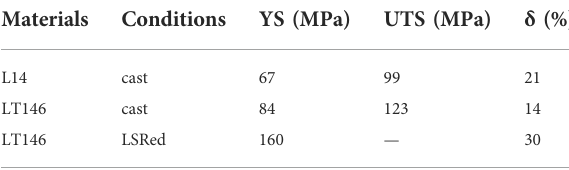
FIGURE 7 TEM images detected from the 15% deformed LT146-LSR alloy. TABLE 2 Tensile properties of the L14 and LT146 at different